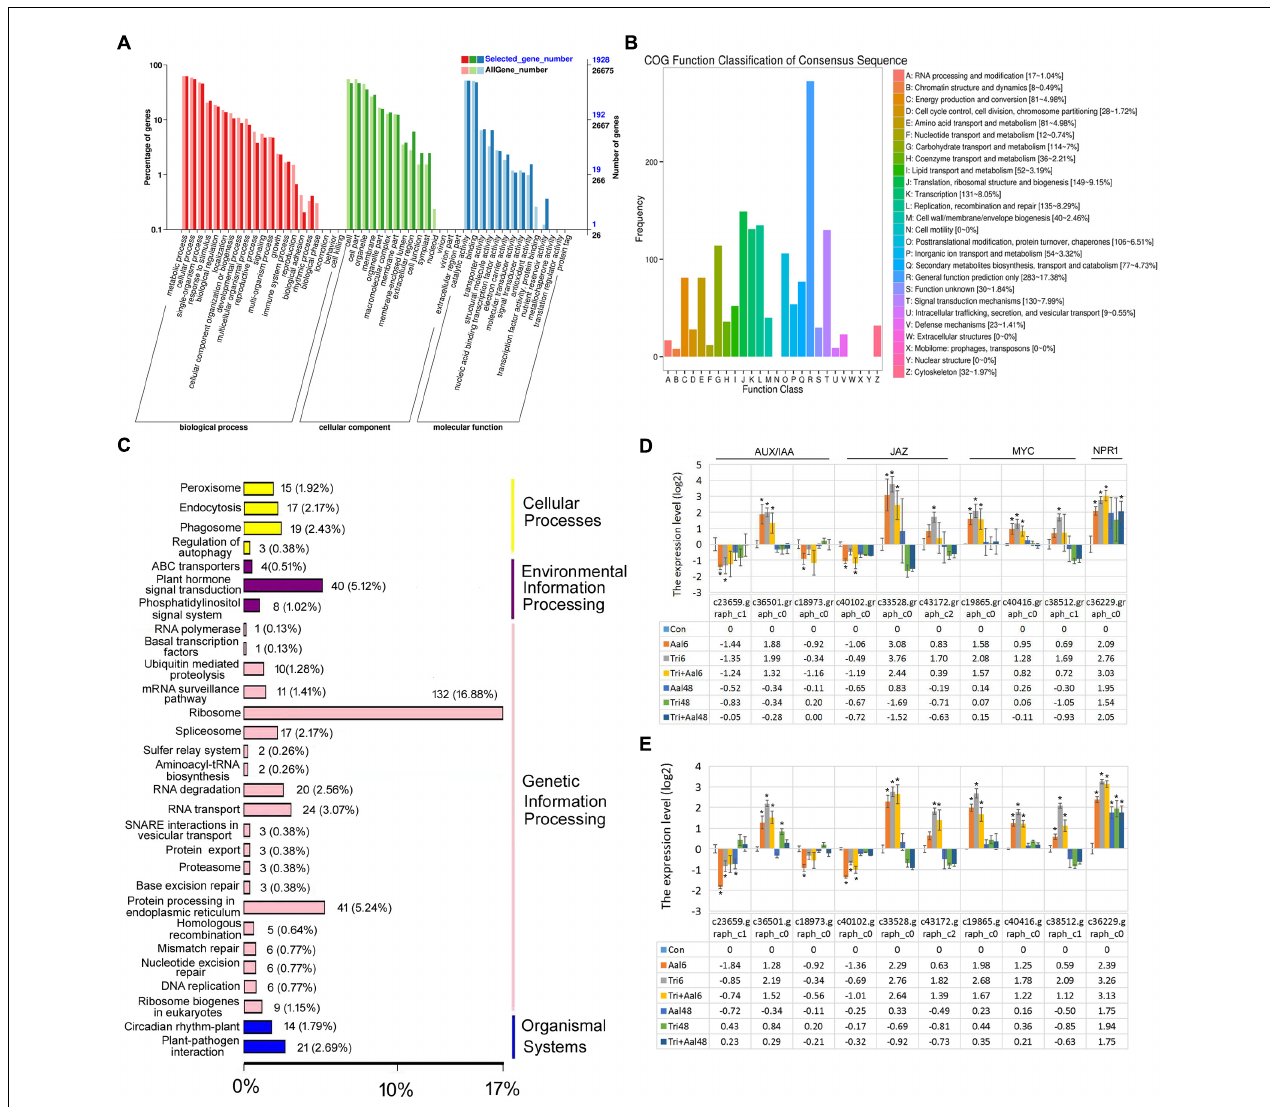
FIGURE 2 | Trichoderma biofertilizer activates the plant hormone signal transduction pathways. (A) GO function analysis after M. sieversii treated with Trichoderma fertilizer for 6 h. (B) COG function classification of consensus sequence after M. sieversii treated with Trichoderma fertilizer for 6 h. (C) KEGG classification analysis after M. sieversii treated with Trichoderma fertilizer for 6 h. (D) DEGs involved in AUX/IAA, JA, and SA, after M. sieversii treated with Trichoderma fertilizer for 6 h. (E) Verify expression of genes in panel (D) using RT-qPCR. The data were counted by RT-qPCR, ANOVA was conducted using Duncan’s method, and p ≤ 0.05 was considered significant. The gene sequences have been deposited in GenBank, c23659.graph_c1 (MZ736861), c36501.graph_c0 (MZ736862), c18973.graph_c0 (MZ736863), c40102.graph_c0 (MZ736864), c33528.graph_c0 (MZ736865), c43172.graph_c2 (MZ736866), c19865.graph_c0 (MZ736867), c40416.graph_c0 (MZ736868), c38512.graph_c1 (MZ736869), and c36229.graph_c0 (MZ736870). COG: Clusters of Orthologous Groups, DEGs: differentially expressed genes, GO: gene ontology, JA: jasmonic acid, KEGG: Kyoto Encyclopedia of Genes and Genomes, RT-qPCR: quantitative real-time PCR, SA: salicylic